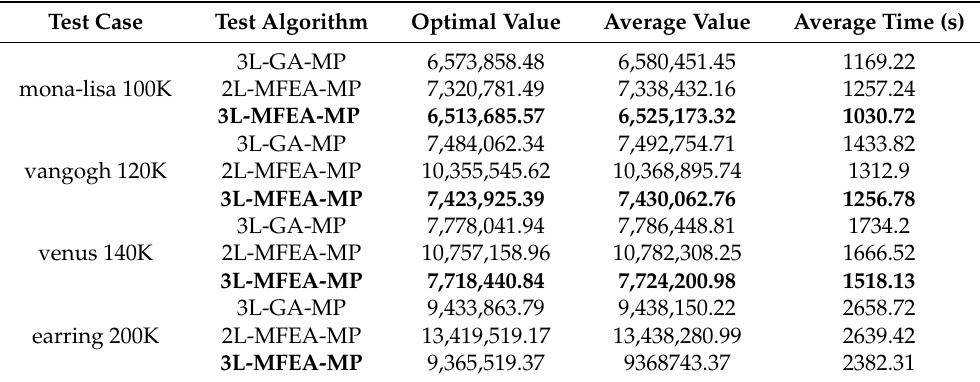
Table 2. Simulation results of three algorithms on four large-scale TSP data